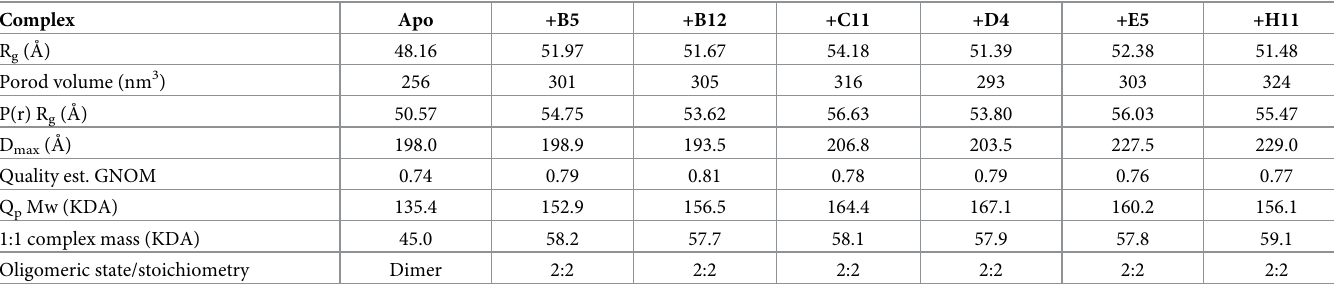
Table 2. Parameters derived from SAXS of FLrArc-7A Nb complexes.